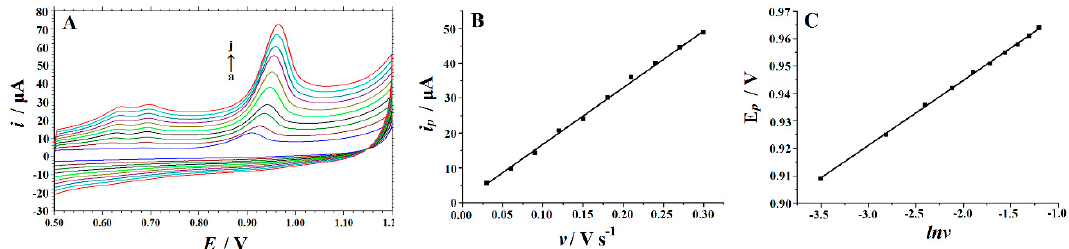
Figure 5. ( A ) Cyclic voltammograms of 10 μ M Trp in 0.05 M H 2 SO 4 solution obtained on the Cu 2 O ‒ ERGO/GCE at different scan rates (a–j: 30, 60, 90, 120, 150, 180, 210, 240, 270, and 300 mV·s − 1 ). ( B ) A plot of the peak current versus scan rate; ( C ) a plot of the peak potential versus the Napierian logarithm of scan rate.